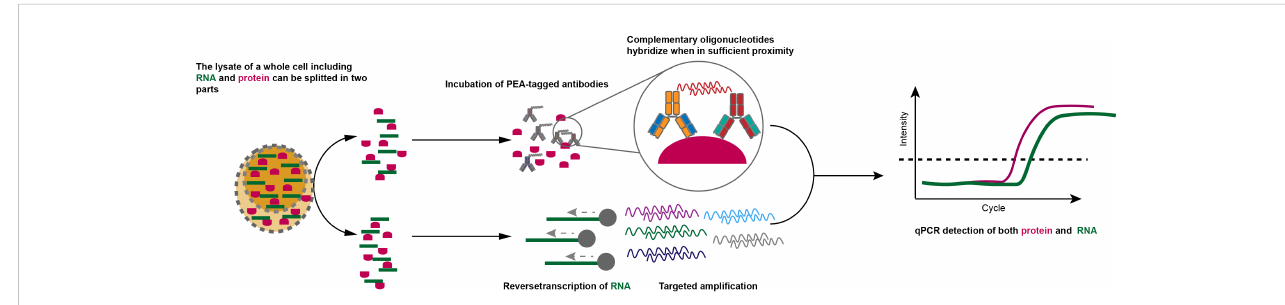
FIGURE 3 PEA approaches for transcriptome and proteome at single-cell resolution. The whole-cell lysis including RNA and protein can be separated into two parts: one is incubated with PEA antibodies for the measurement of speci fi c proteins via qPCR and one is for quanti fi cation of cDNA by